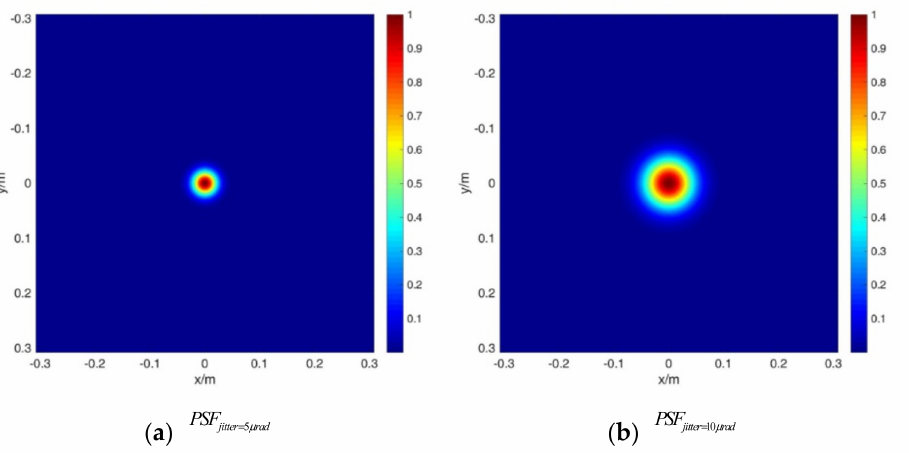
Figure 2. The PSF results for ( a ) jitter = 5 µ rad and ( b ) jitter = 10 µ rad